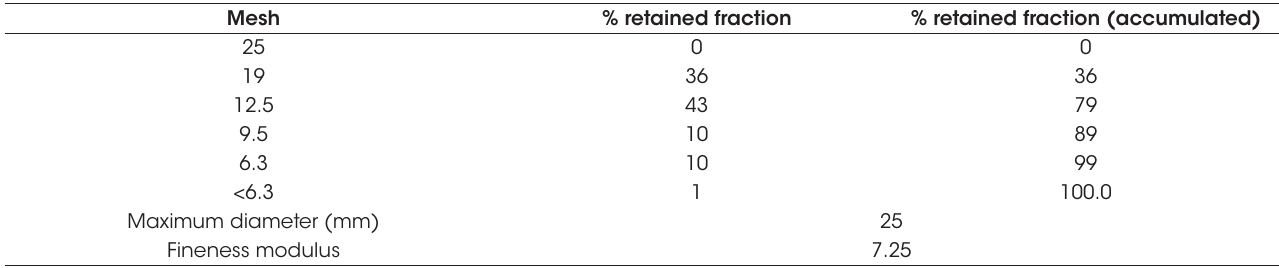
Grain size distribution of the recycled concrete aggregate